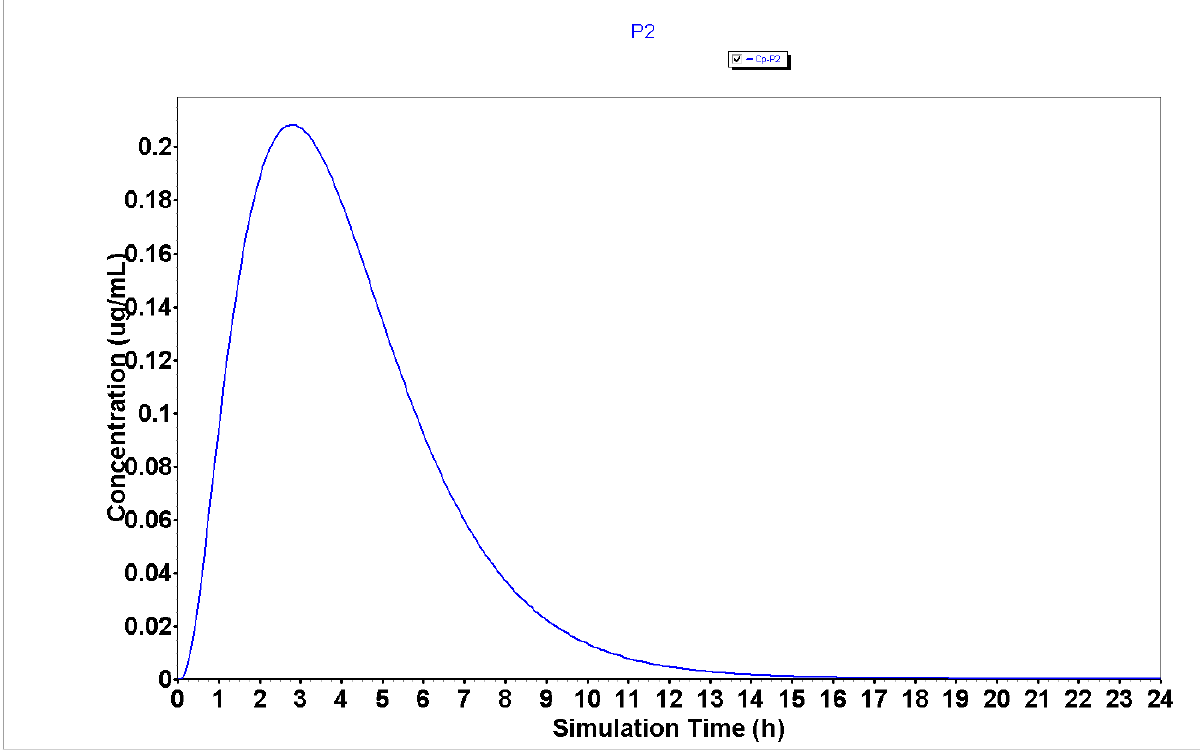
Figure 5. Plasma concentration of P2 generated using the GastroPlus ® software.